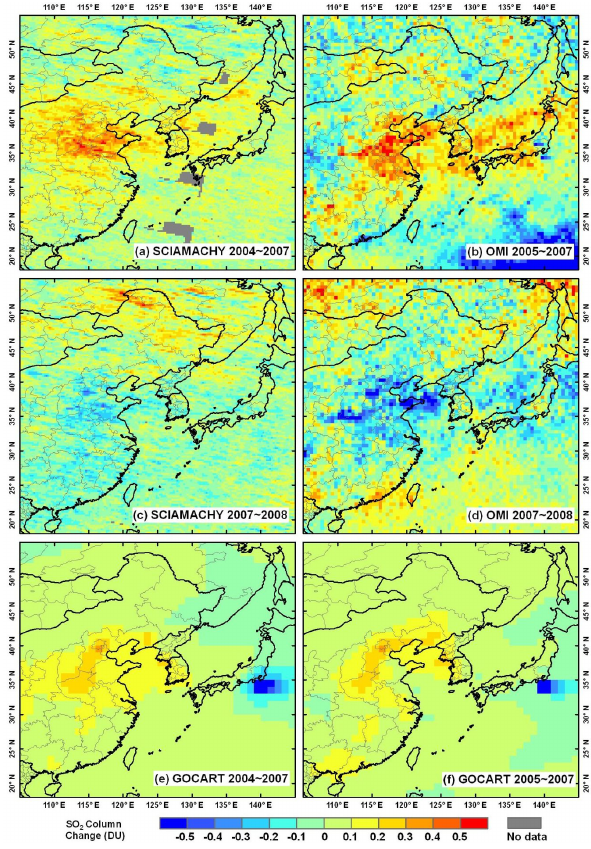
Fig. 6. Differences in annual SO 2 vertical columns of boundary layer from satellite retrievals: (a) SCIAMACHY, 2004–2007, (b) OMI, 2005–2007, (c) SCIAMACHY, 2007–2008, (d) OMI, 2007– 2008, and total SO 2 columns predicted by the GOCART model: (e) GOCART, 2004–2007, (f) GOCART,